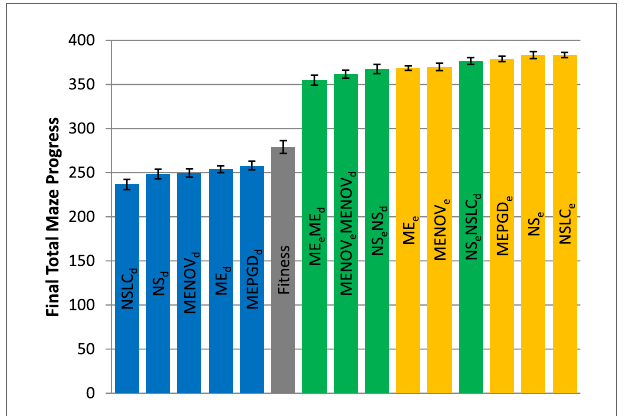
FigUre 5 | Total maze progress (symmetric gauntlet) . The final total maze progress achieved by each of fifteen treatments ( Table 2 ) after 1,000,000 evaluations on the symmetric gauntlet is shown (averaged over 20 runs). Bars are color coded according to which BC drives search (see section 6) and error bars represent SE. A maximum possible score of 400 corresponds to solving all four legs of the maze.